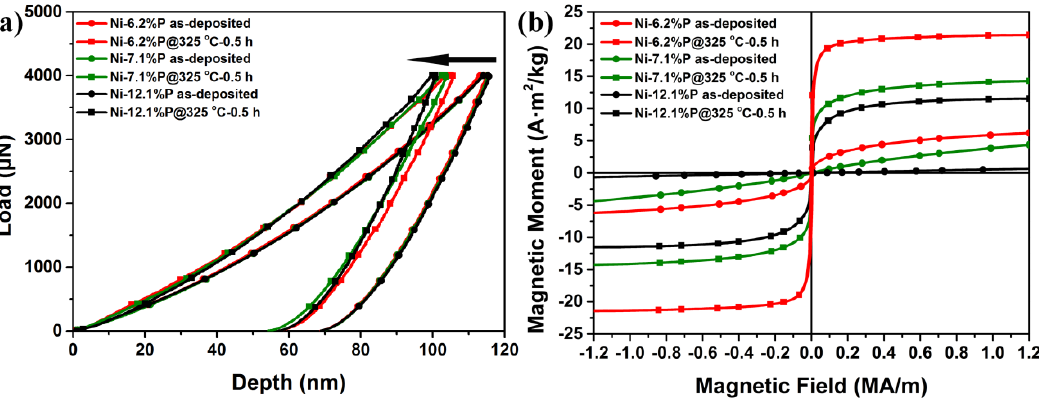
Figure 1. Typical displacement-load curves ( a ) and magnetic hysteresis loop curves ( b ) of as-deposited and 325 °C for 0.5 h annealed NC Ni-P alloys.